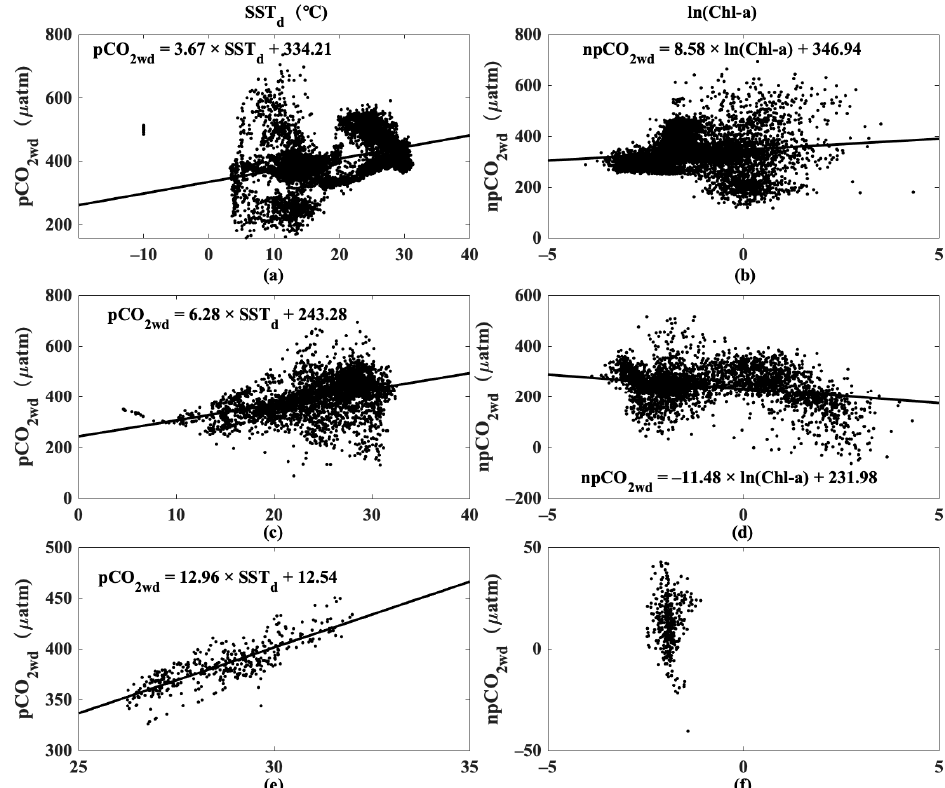
pCO and SST d Figure 13. Regional algorithm for 2010–2020, showing the fitting results between pCO 2wd and SST d 2wd